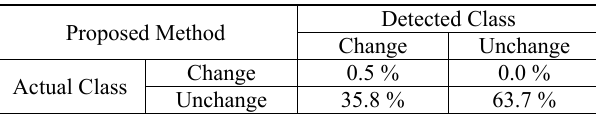
Table 3 . Results of the subtraction (depth image).